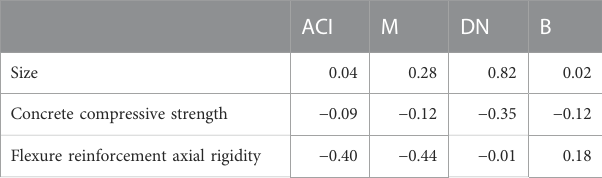
TABLE 4 Correlation coef fi cient between various methods and